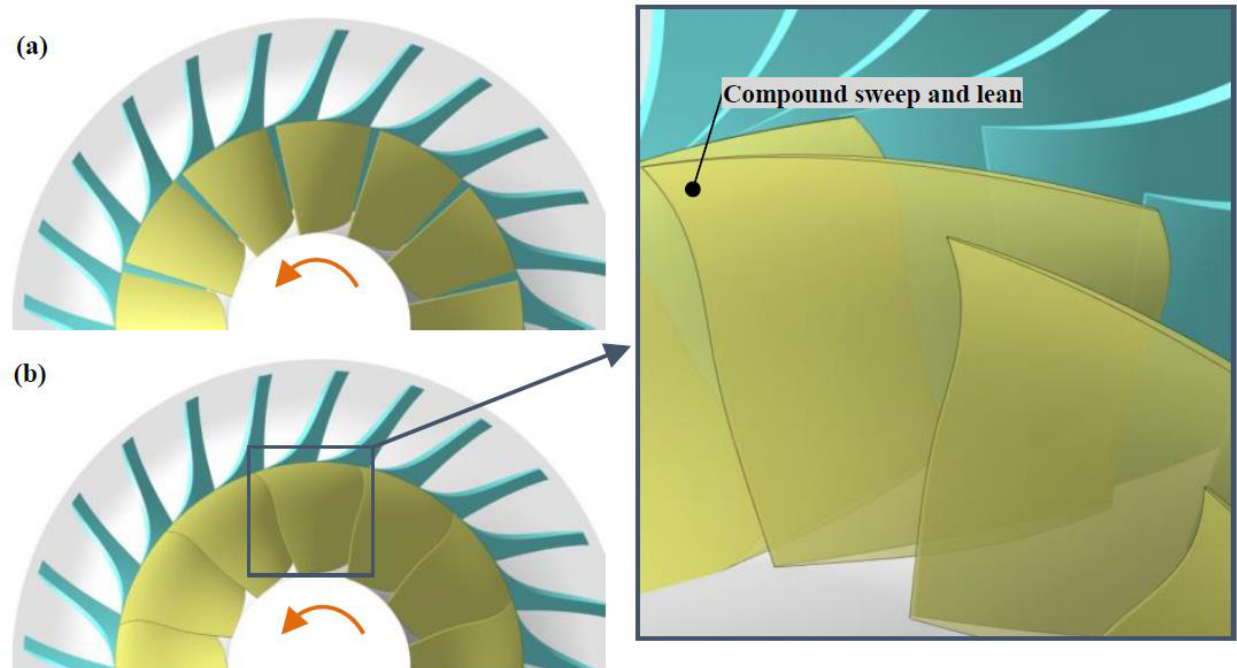
Figure 21. Illustration of the tandem impeller with and without the free-formed inducer design. ( a ) Baseline tandem impeller, and ( b ) free-formed tandem impeller.